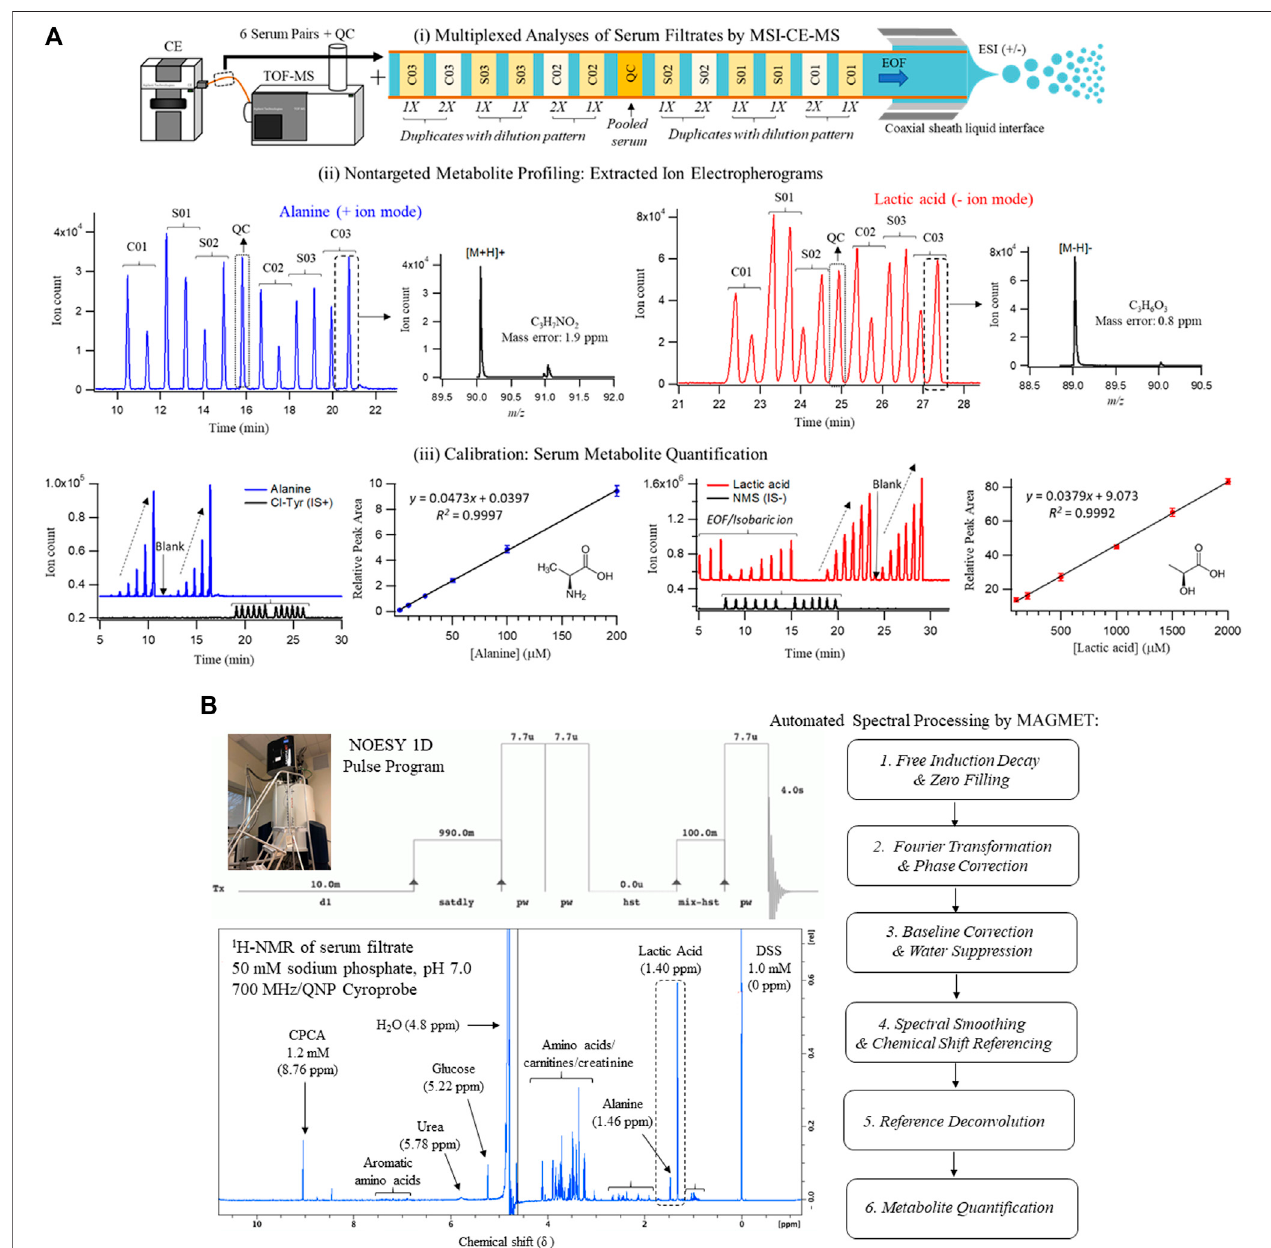
FIGURE 1 | Cross-platformmethodcomparisonforcharacterizationoftheserummetabolomefromHCVpatientswithliver fi brosisandnon-HCVcontrolswhenusing (A) MSI-CE-MSand (B) 1 H-NMR.Inbothcases,dilutedserum fi ltratesampleswereanalyzedusingstandardizedprotocols,whichincluded60and30polar/ionicmetabolites measured in most samples ( > 75%) with adequate precision (CV < 35%) by MSI-CE-MS and NMR, respectively. Each sample was analyzed by NMR with signal averaging (120 scans, 12 min/sample) followed by automated spectral processing by MAGMET using a targeted metabolite library, whereas six pairs of serum fi ltrates together with a pooled QC were analyzed in each MSI-CE-MS run (8 min/sample) using both targeted and nontargeted approaches with metabolite quanti fi cation using external calibration curves with internal standards. Serum metabolite concentrations measured consistently by both platforms are illustrated in this case for alanine and lactic acid.